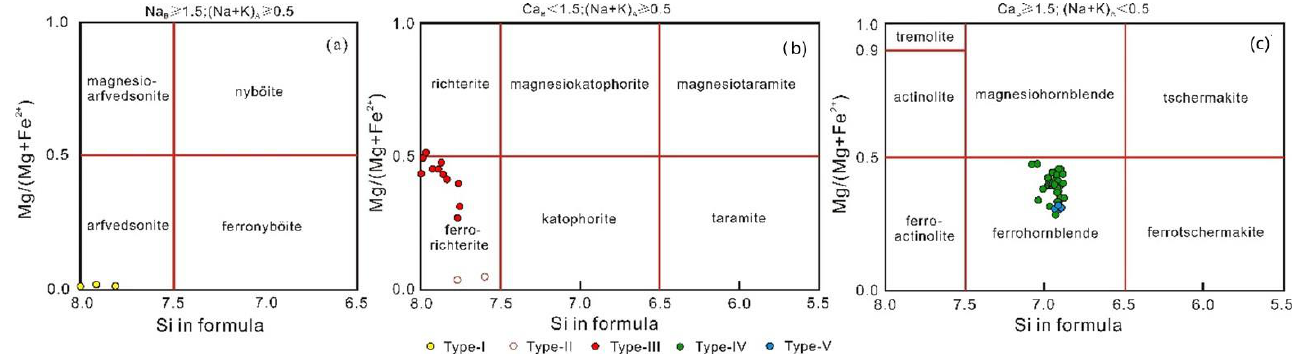
Figure 5. Classification diagrams of ( a ) sodic, ( b ) sodic ‒ calcic, and ( c ) calcic amphiboles (after [57]). Symbols are as in Figure 4.